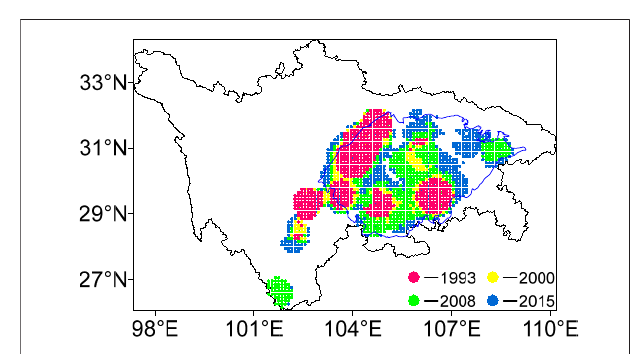
FIGURE 3 | Spatial expansion of Sichuan – Chongqing urban areas at four representative stages in 1993, 2000, 2008, and 2015.